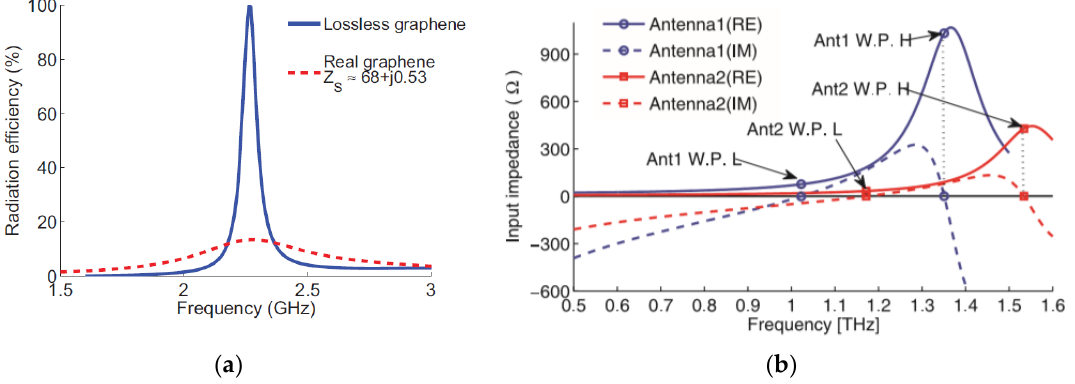
Figure 2. Analysis of ( a ) radiation efficiency of an ideal lossless antenna and real graphene-based patch antennas at microwaves [5] and ( b ) Input impedance Z in of the proposed antennas. The arrows indicate the real impedance W.P. [7]. (With permission from IEEE and AIP)